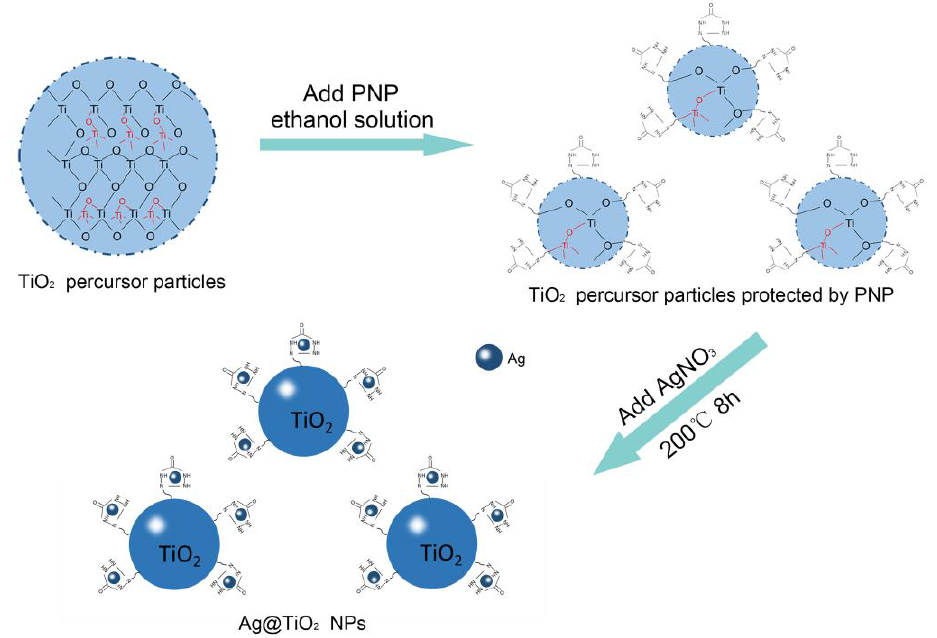
Figure 1. SEM images of TiO 2 nanoparticles (NPs) with different molars of polyamide network polymers (PNP): 0 mol ( a ), 0.25 mol ( b ), 0.5 mol ( c ), 1 mol ( d ), 2 mol ( e ) and 3.125 mol ( f ), respectively.